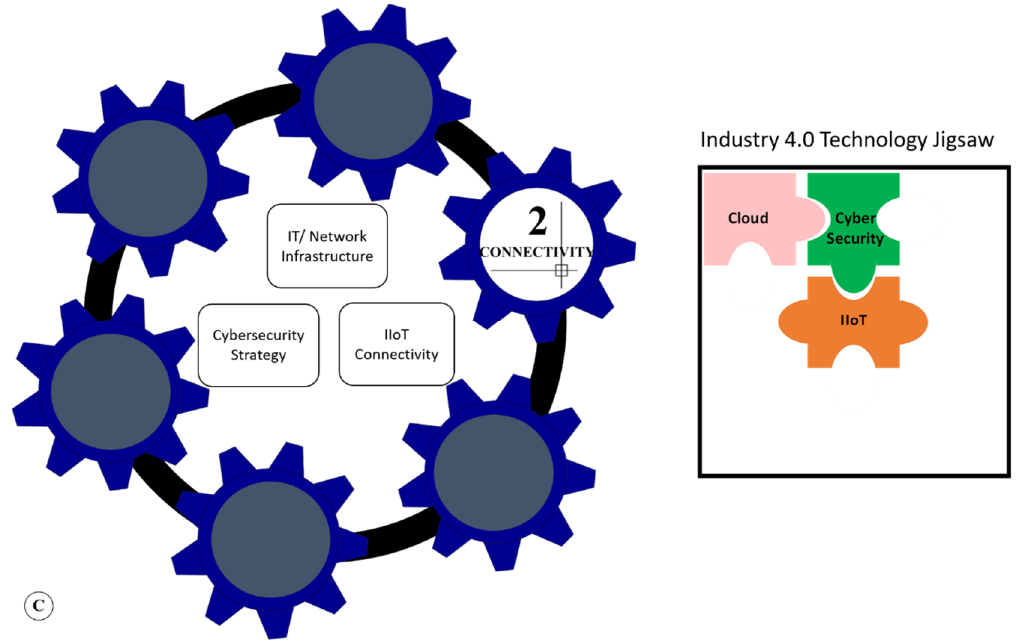
Figure 6. Gear 2—connectivity stage and Industry 4.0 technology jigsaw.